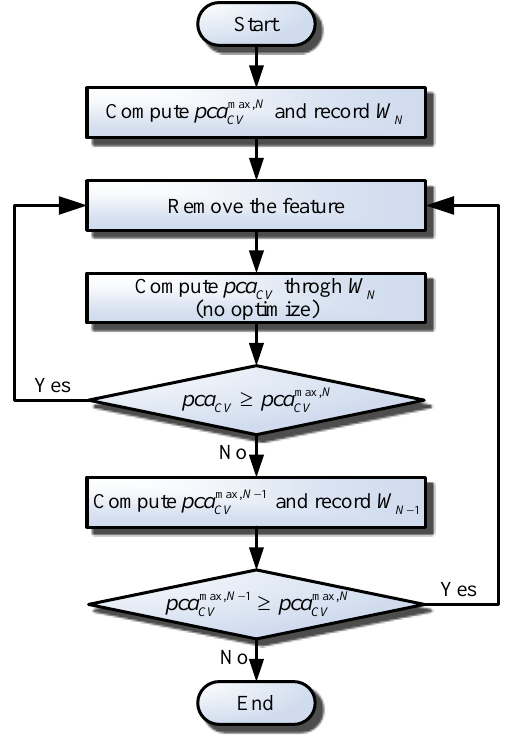
Figure 5. Flowchart of feature selection.